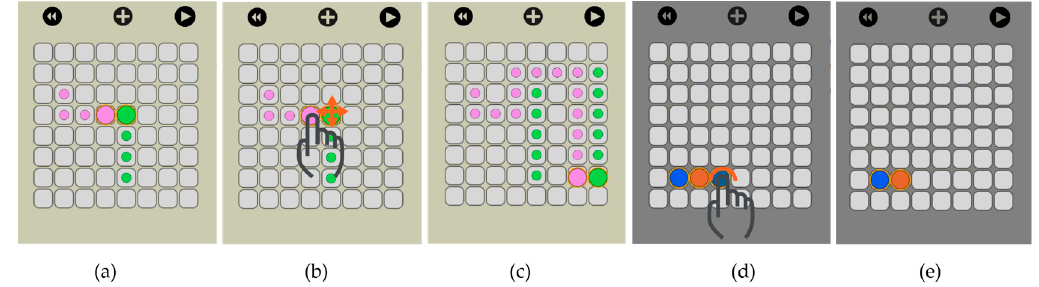
Figure 12. ( a ) When two droplets meet, they instantly merge together and ( b ) the user can manipulate them as a single entity using finger drag; ( c ) The merged droplets follow the drag as a unit; ( d ) In delete mode, with a single tap, the user can ( e ) delete droplets.